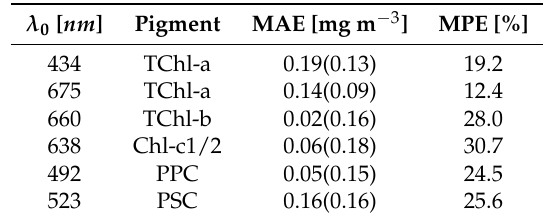
Table 8. Statistics of phytoplankton pigments retrieval using Gaussian decomposition with package effect normalization based on leave-one-out cross-validation. Package effect normalization was performed with c TChl - a in Equation (7) calculated using cruise-specific a ph ( 675 ) (AC-S)-TChl-a (HPLC) relationships (see Section 3.1). MAE values outside the parentheses were calculated with linear-scale values, while inside the parentheses with log10-scale